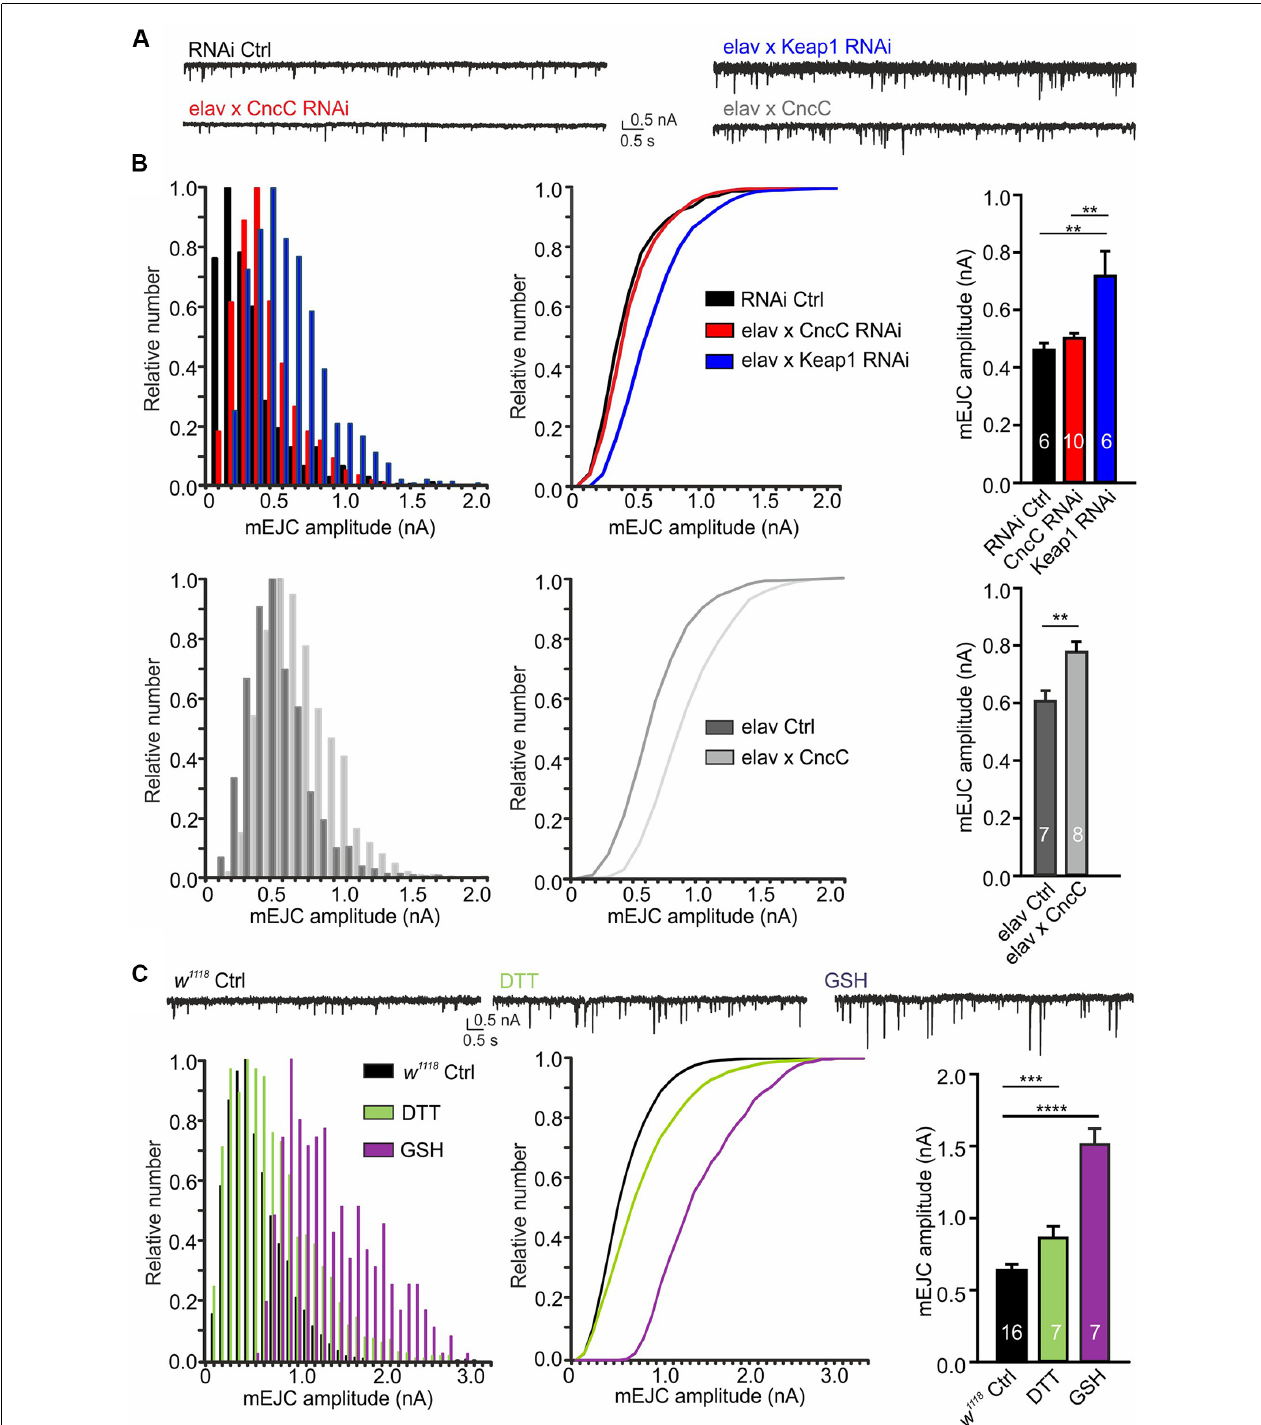
FIGURE 2 | Upregulation of antioxidant signaling enhances spontaneous quantal release at the neuromuscular junction (NMJ) synapse. (A) Example recordings of spontaneous activity at larval NMJs. (B) Overexpression of CncC and silencing of Keap1 enhances the quantal size, illustrated in amplitude frequency plots for miniature excitatory junctional current (mEJC) amplitudes (left), cumulative amplitude frequency plots (middle) and mean bar graphs (right). (C) Exposure to antioxidants dithiothreitol (DTT) and glutathione (GSH) induced a strong increase in quantal size at NMJs of w 1118 larvae as illustrated in frequency plots for mEJC amplitudes (left), cumulative amplitude frequency plots (middle) and mean bar graphs (right). One-way ANOVA with post hoc Tukey-Kramer was used for comparisons with ∗∗ p < 0.01, ∗∗∗ p < 0.001, ∗∗∗∗ p < 0.0001 [ n —number of NMJs (from at least three larvae) indicated within bars].